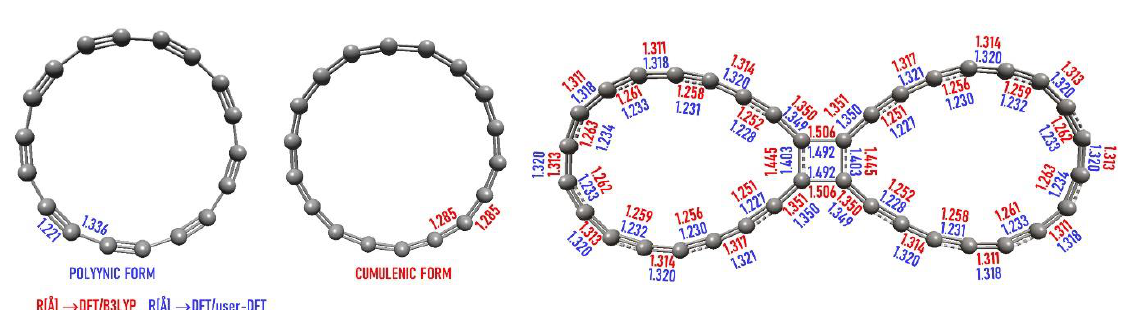
Figure 3. The bond lengths for the polyynic and cumulenic forms of cyclo[18]carbon and for its dimeric S0-C 36 structure obtained at the DFT/B3LYP (red) and the DFT/user-DFT (blue) level. Thus, in both cases the electronic structure of C 36 is the same with the same “polyynic” began to generate bigger